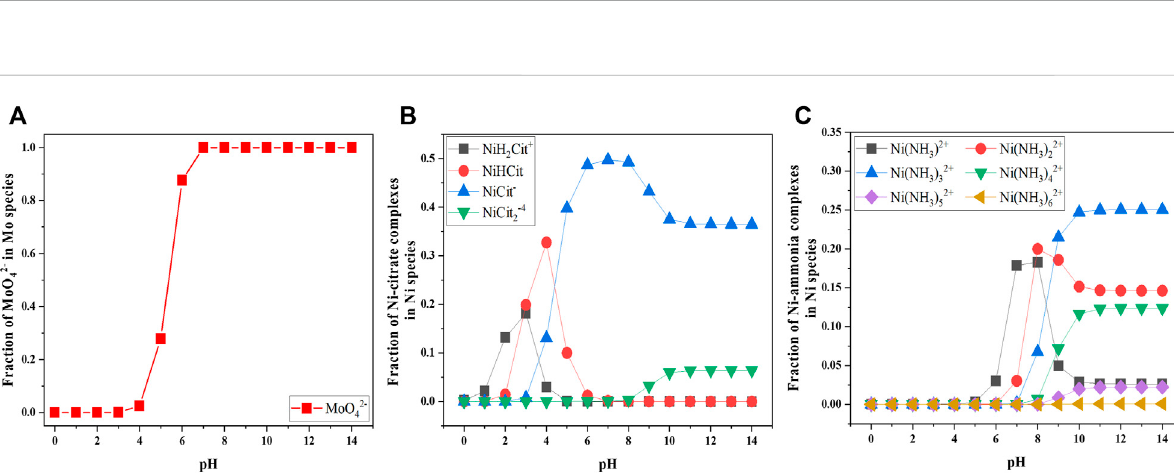
programming and numeric computing platform (i.e., MATLAB from Mathwork ® ) to simulate the fraction of species as shown in Figure5, fi vepHconditions(i.e., 4 – 6,8and10)wereselectedtostudy a wide range of fraction of MoO 4 2 − ions. Moreover, the lower